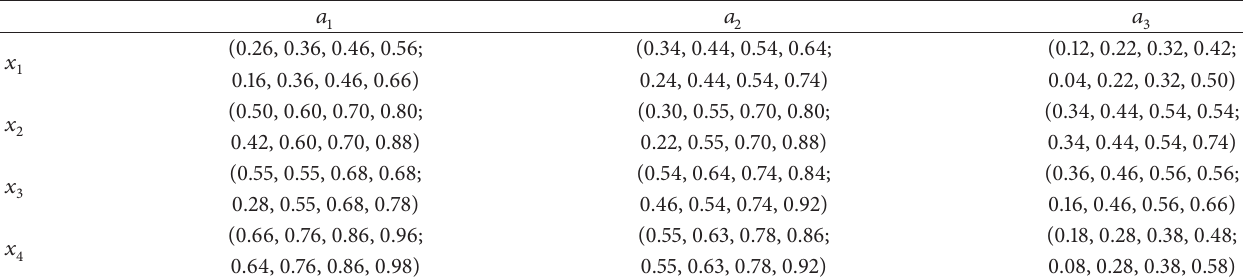
Table 1: TrIFNs decision